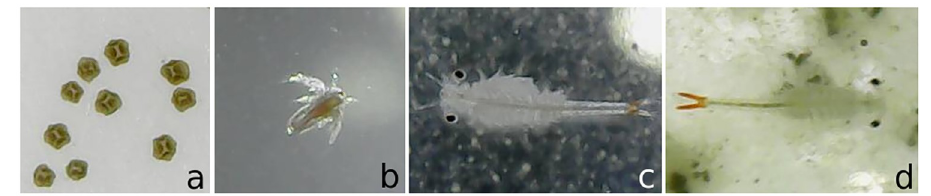
Fig 1. Life stages of Dendrocephalus brasiliensis : a) cysts, b) nauplius, c) juvenile, and d) adult.